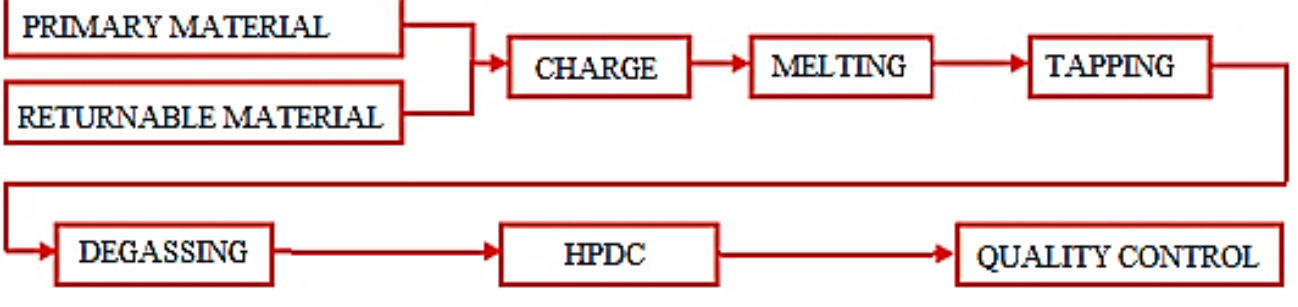
Figure 1. Technological flow of alloy in the production of HPDC cast.